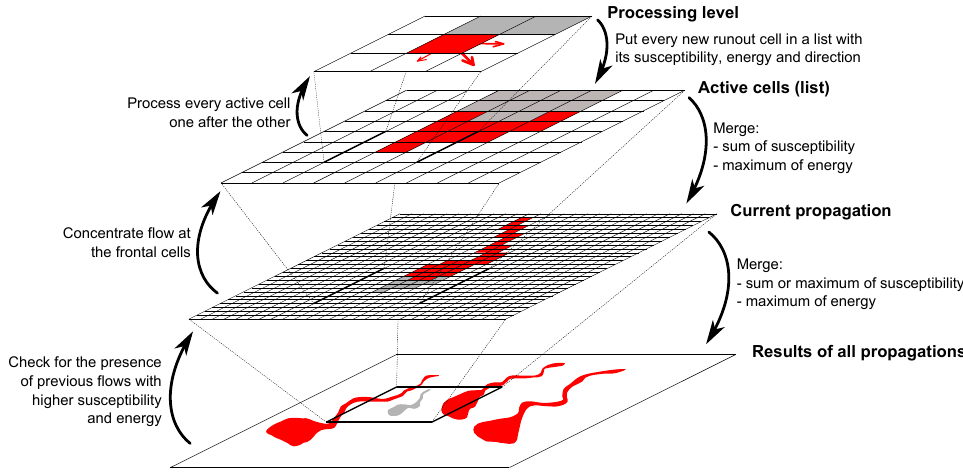
Fig. 7. Illustration of the 4 different layers of processing of the propagation and their associated data flow.